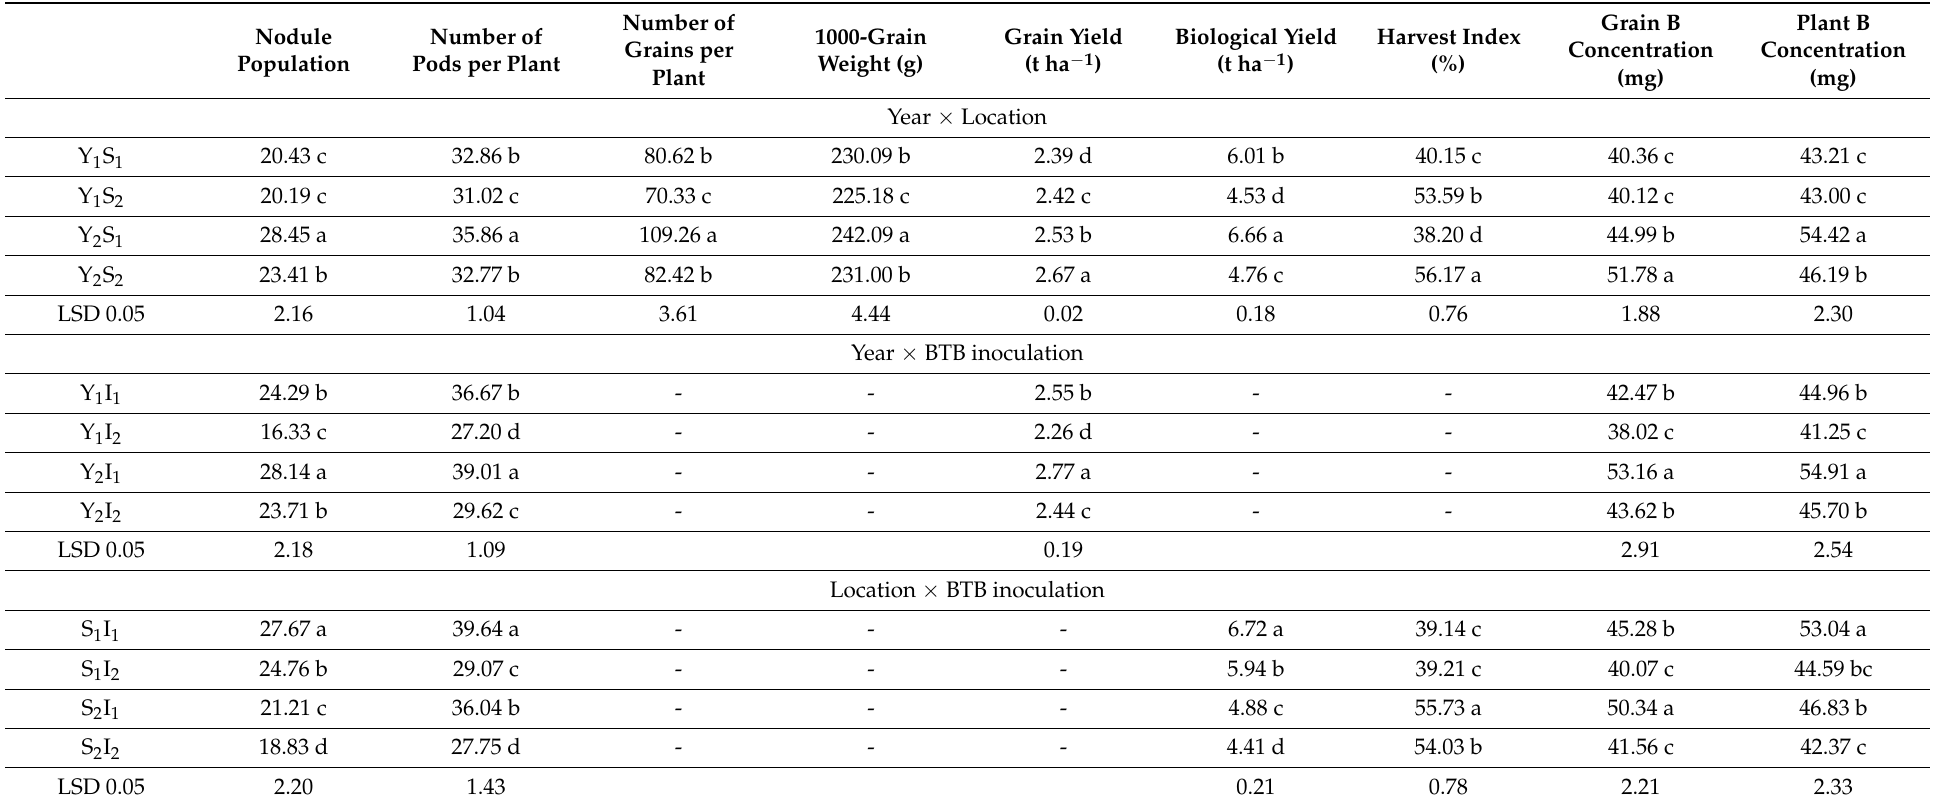
Table 4. The impact of year by location, year by BTB ( Bacillus sp. MN54) inoculation and location by BTB ( Bacillus sp. MN54) inoculation interaction on growth and yield-related traits of desi